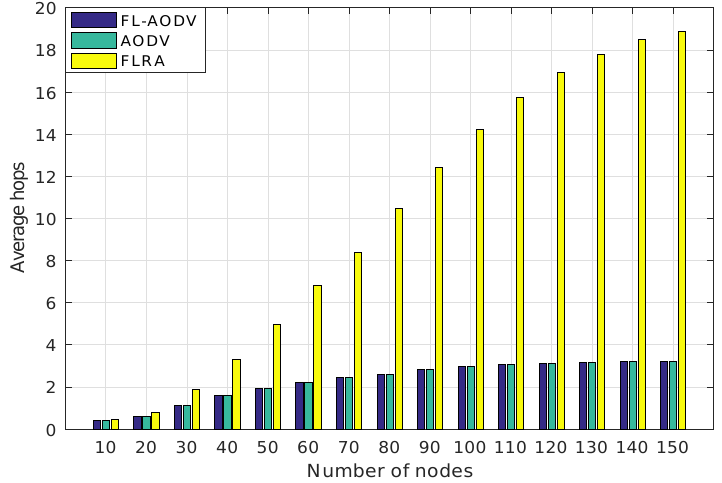
Figure 11. Comparison of average path hops.